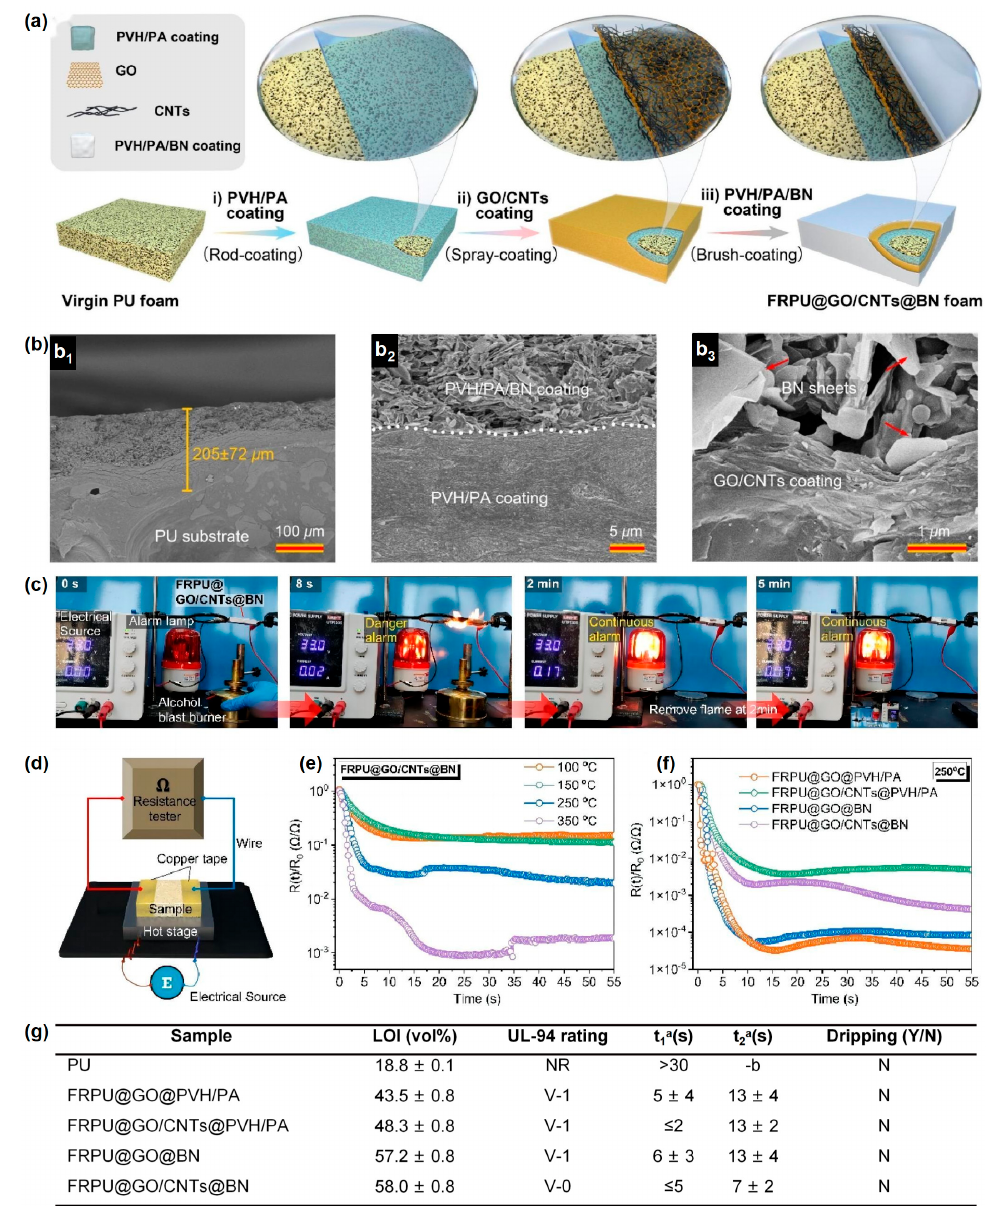
Figure 18. ( a ) Schematic diagram of the preparation of FRPU@GO/CNTs@BN foam. ( b ) SEM photographs of the FRPU@GO/CNTs@BN cross-section morphology at various magnifications. ( c ) Flame detection of FRPU@GO/CNTs@BN. ( d ) The apparatus for sensing resistance variation with temperature. ( e ) The FRPU@GO/CNTs@BN electrical resistance varies in real-time as a function of temperature. ( f ) Coated PU foams’ electrical resistance variations over at 250 °C. ( g ) LOI and